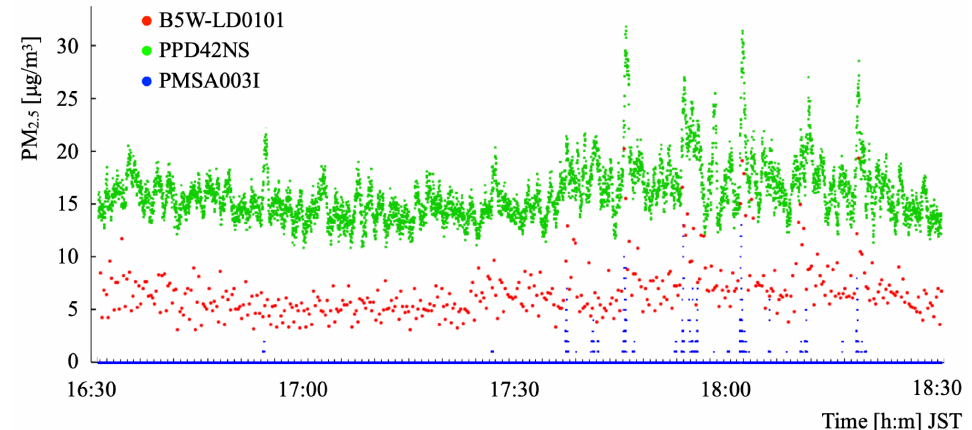
Figure 11. Time-series changes of PM 2.5 from three